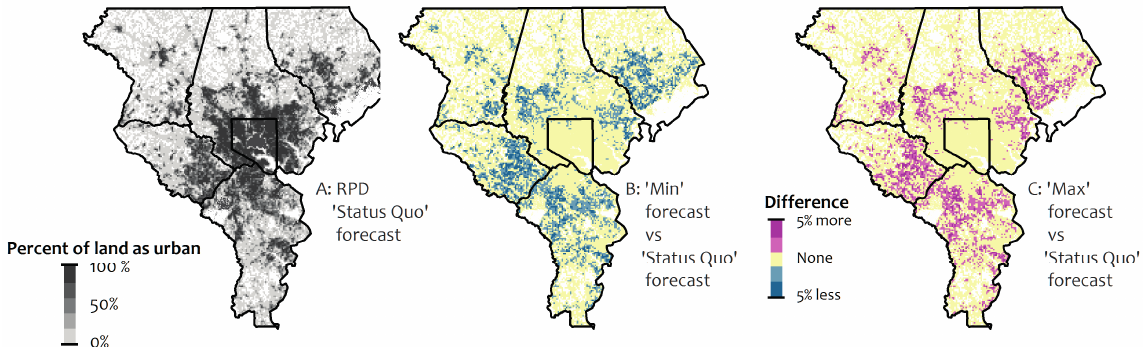
Figure 9. Graph showing constrained forecast results for SQ, MIN, and MAX scenarios run with the RPD exclusion/attraction